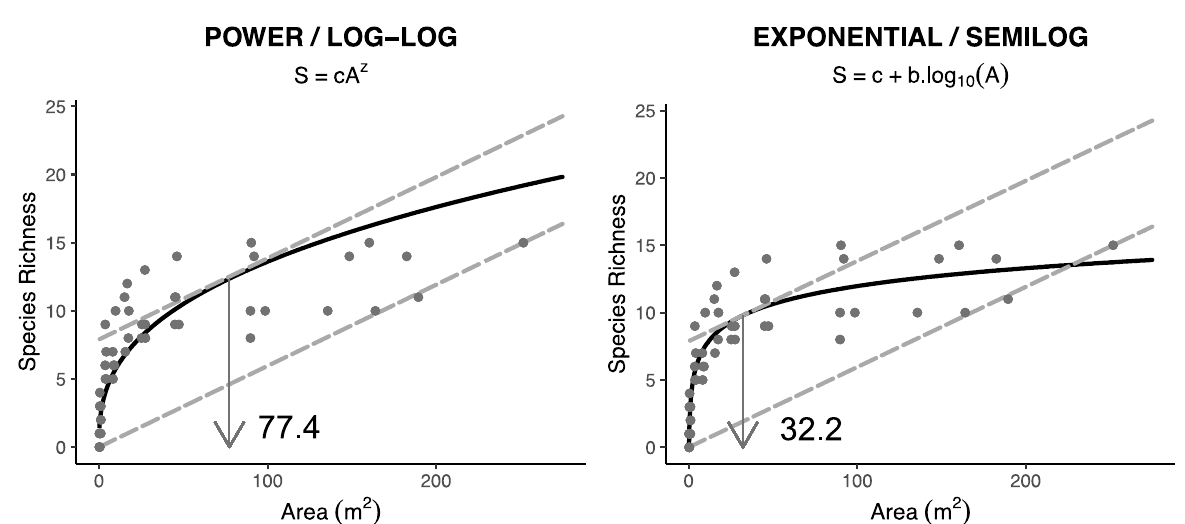
Figure 6. Power and exponential species-area curves at La Soledad, including derived values of minimum